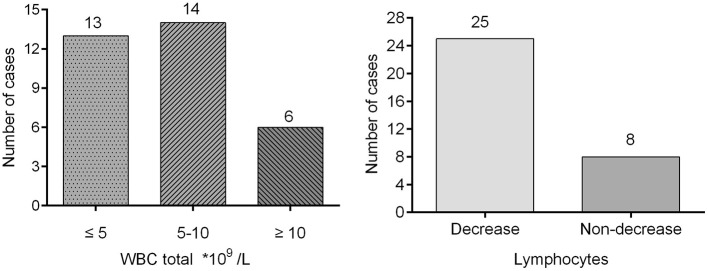
Laboratory test.